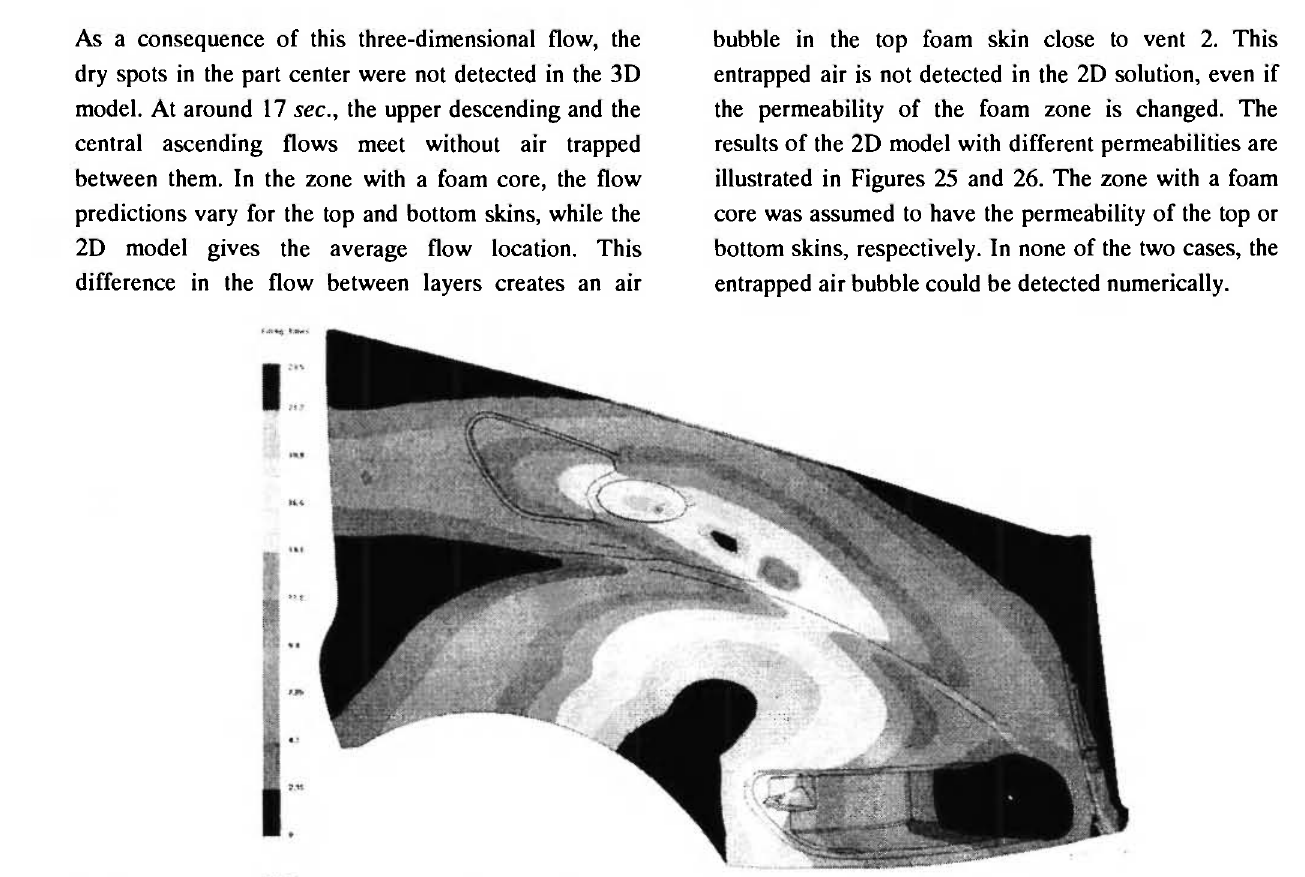
Fig. 25: Predicted flow front positions with the triangular mesh with the bottom foam skin permeability. A filling time of 23.5 sec was